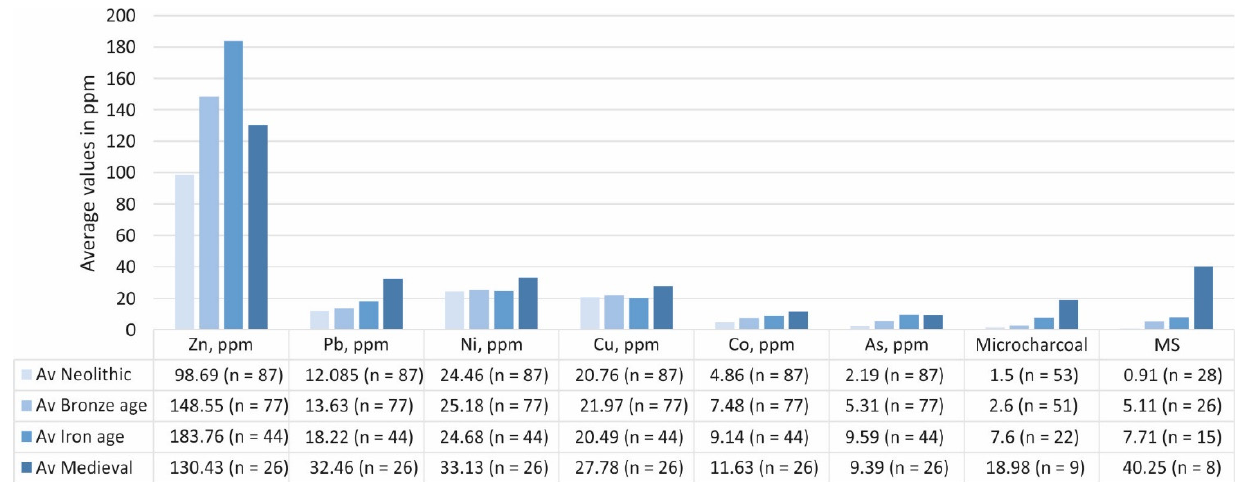
Figure 2. The average values of element concentrations in the Kamyshovoe Lake sediments according to historical period.